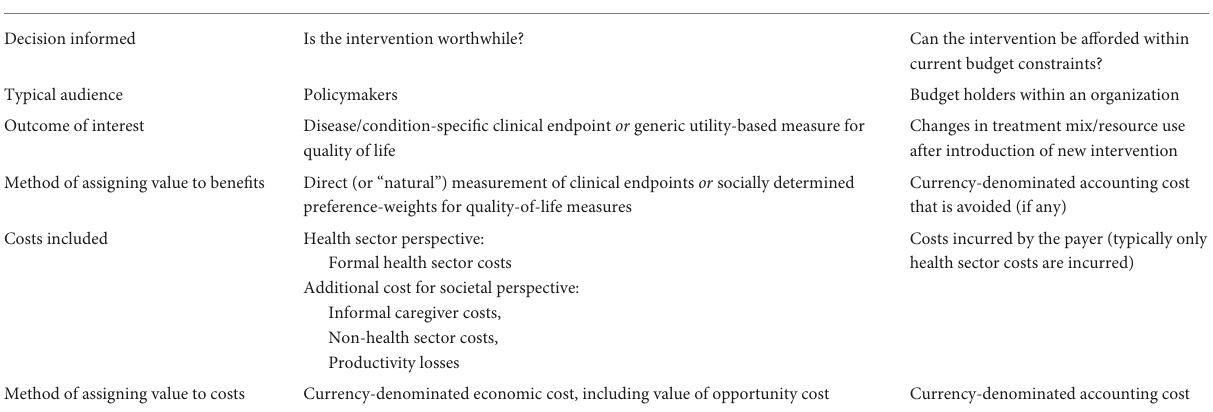
TABLE 1 Comparison of cost effectiveness and budget impact